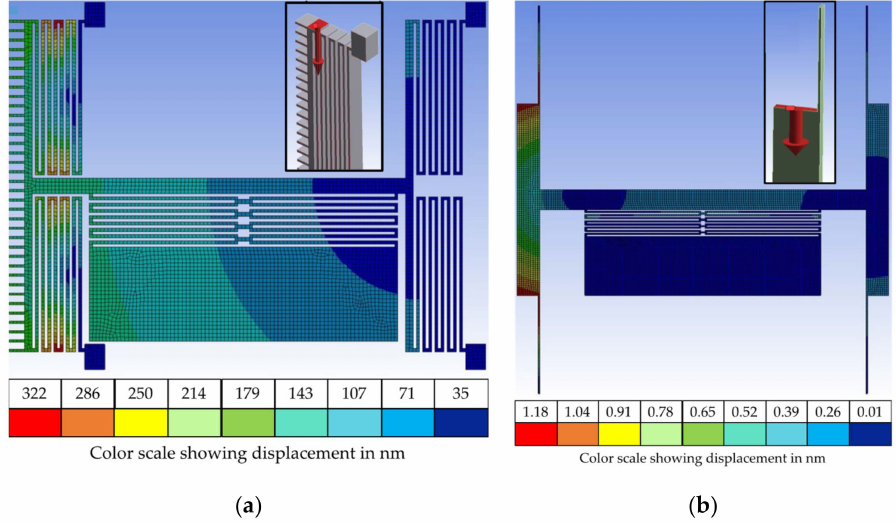
Figure 6. Total deformation heatmap when 10 µ N of force is applied on the top left corner of the structure (force location shown in image insets): ( a ) comb drive and serpentine spring design; ( b ) parallel plate and single beam spring